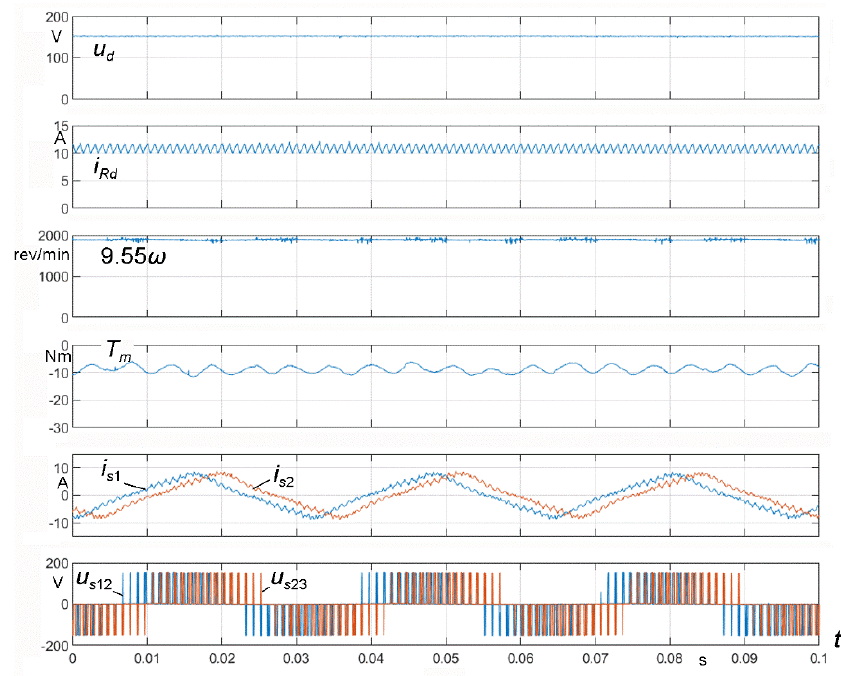
Figure 16. Steady-state waveforms corresponding to case C in Figure 13 at Ω pu = 0.96, m = 1.